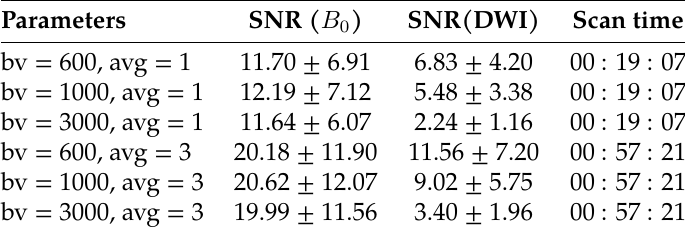
Table 3: SNR and acquisition times in raw data acquired at 0.4mm 3